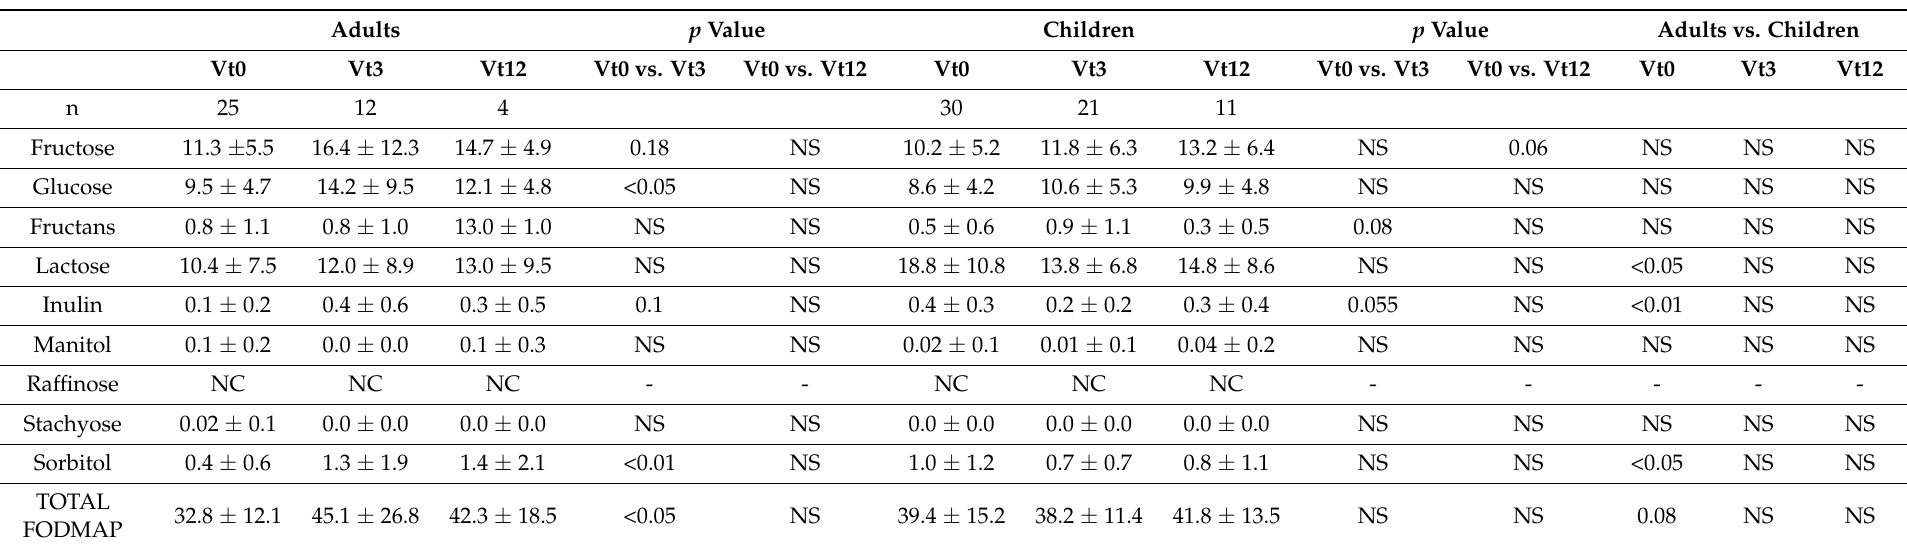
Table 5. FODMAP consumption (g/day) of celiac adults and children (mean ±